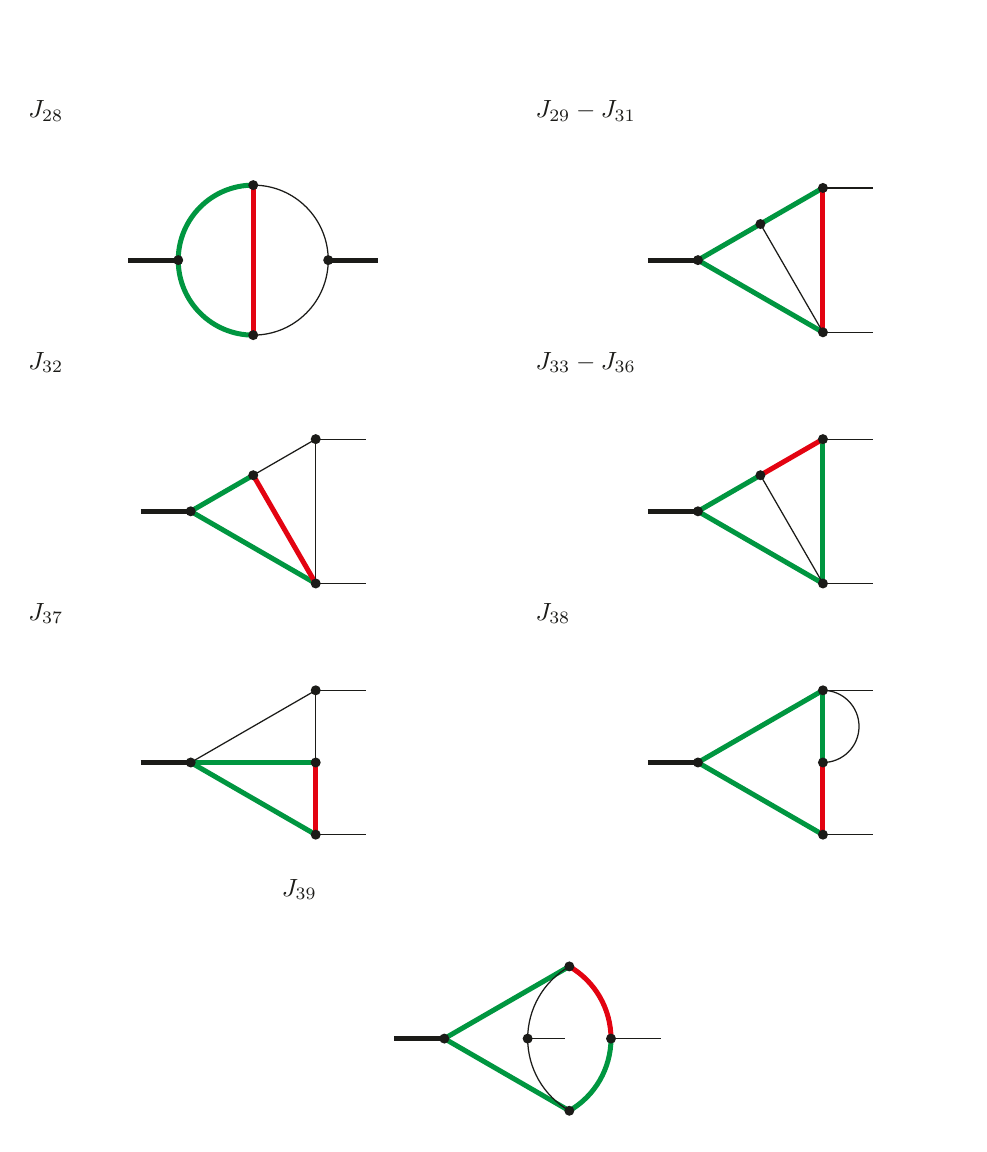
Figure 6 . Master topologies (part